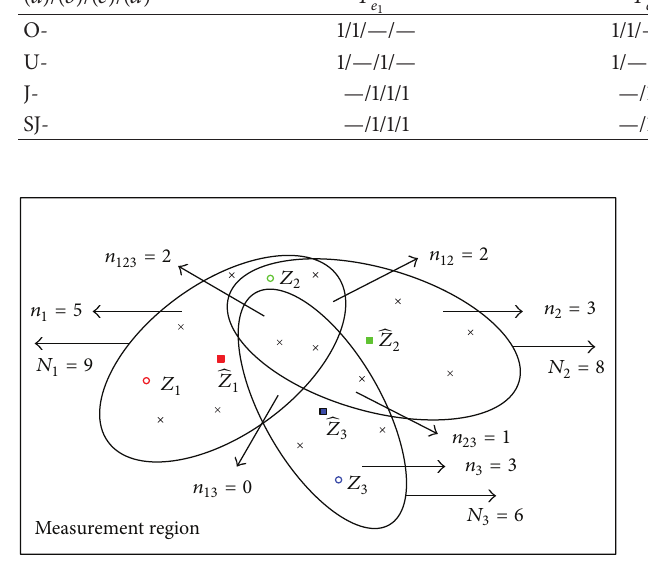
Figure 5: Example of measurement validation regions for tracking three